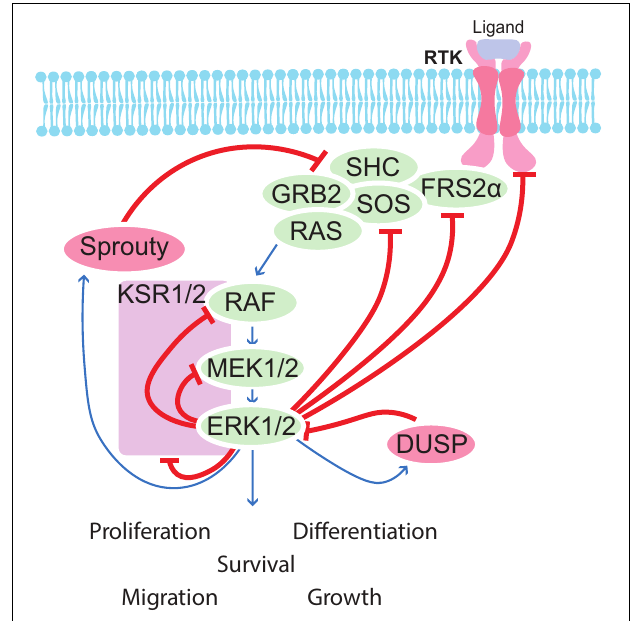
FIGURE 5 | Schematic overview of feedback regulation of the MAPK pathway. Several feedback mechanisms are in place to control the MAPK pathway. ERK1/2 phosphorylates many upstream components and induces transcription of regulators such as Sproutys and DUSPs, which help to balance correct signaling strength in a given